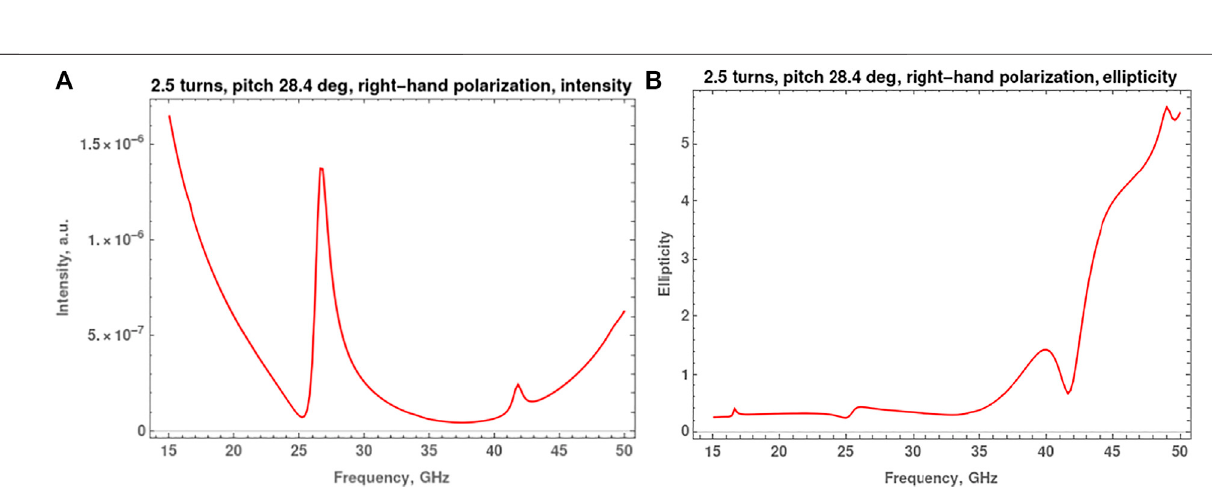
Frontiers in Nanotechnology |